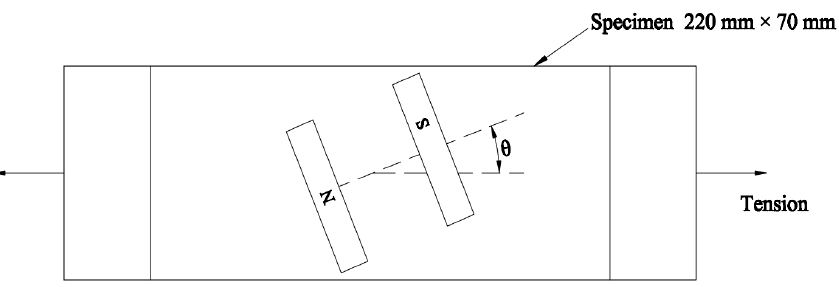
Figure 6. Position of the U-shaped electromagnet on the test specimen. θ = 0°, 22.5°, 45°, 67.5°, and 90°.